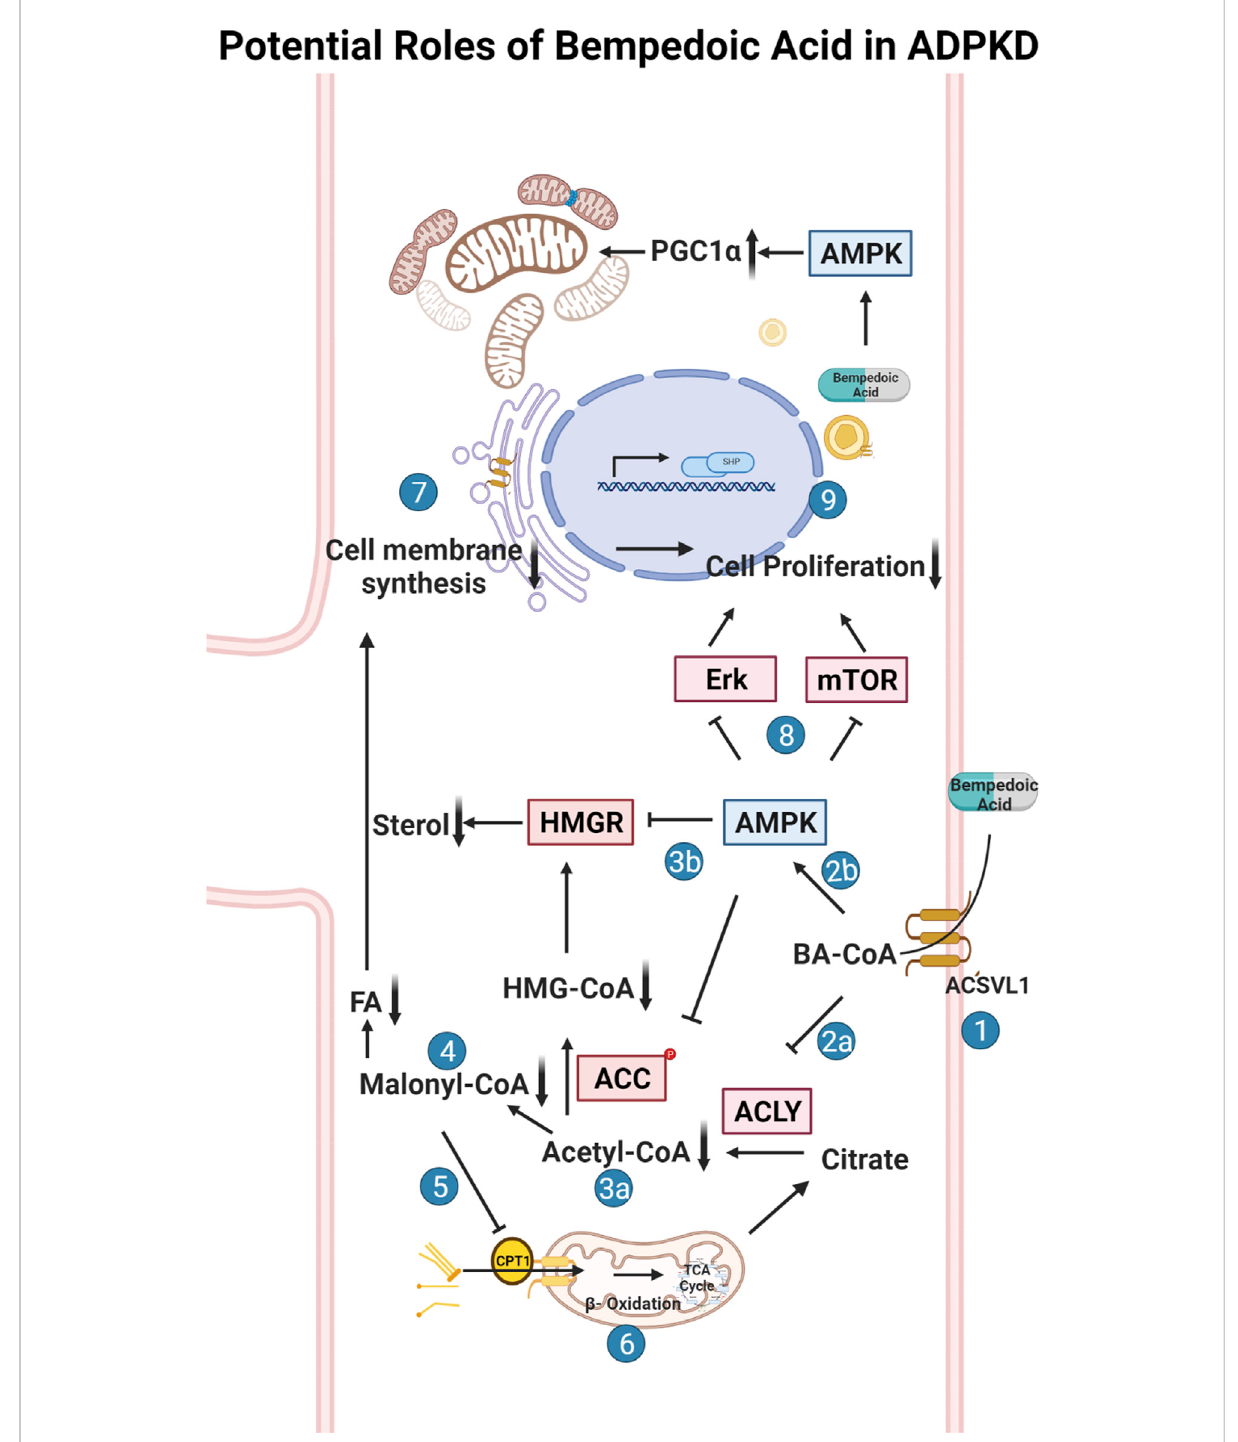
Potential roles of bempedoic acid (BA) in ADPKD. Schematic fl ow diagram of the effects of bempedoic acid (BA; a.k.a. ETC-1002) on various metabolic pathways and cellular proliferation via inhibition of ATP-citrate lyase (ACLY) and activation of AMP-activated protein kinase (AMPK). 1. The pro-drugBAgetsconvertedtoitsactiveform(BA-CoA) via VeryLong-ChainAcyl-CoASynthetase(ACSVL1;a.k.a.FATP2),whoselongisoformisonly substantially expressed in liver and kidney tissues (Steinberg et al., 1999; Pinkosky et al., 2016). BA-CoA simultaneously inhibits ACLY (2a) and activates AMPK (2b) in cells. Inhibition of ACLY, which converts citrate to acetyl-CoA and oxaloacetate, results in decreased cytosolic acetyl-CoA